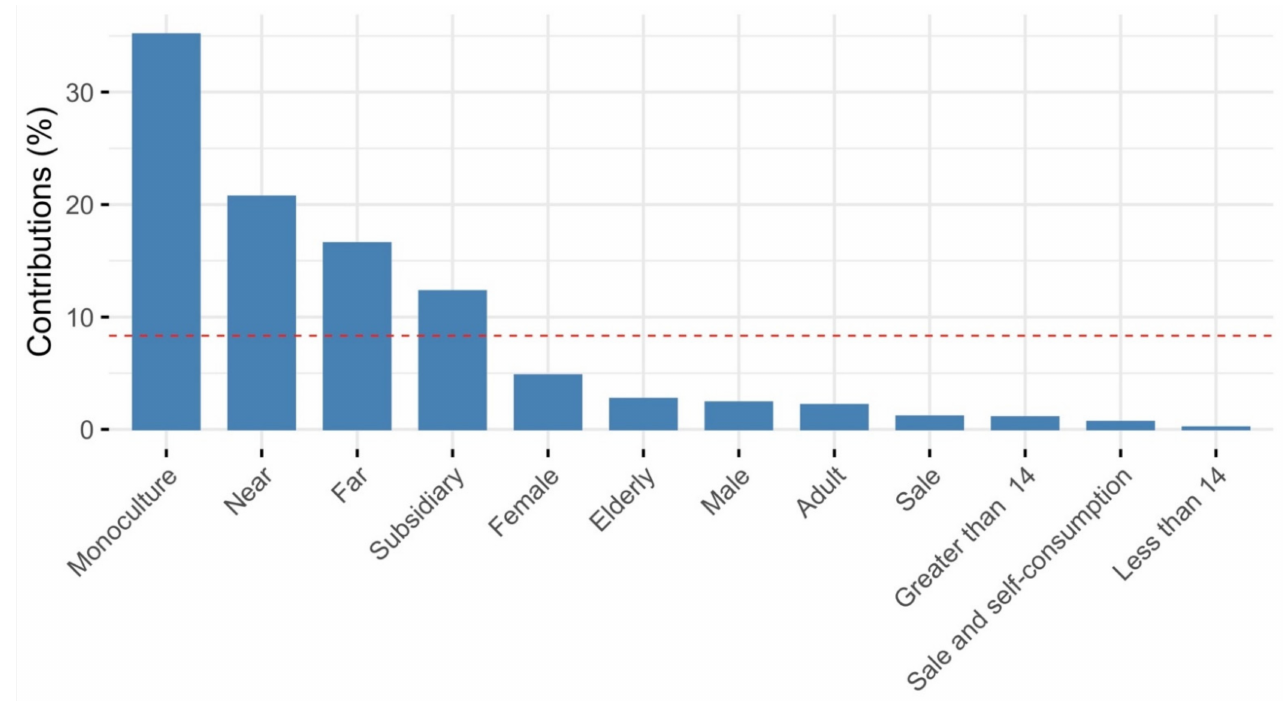
Figure A3. Contribution of variables to dimension 2.